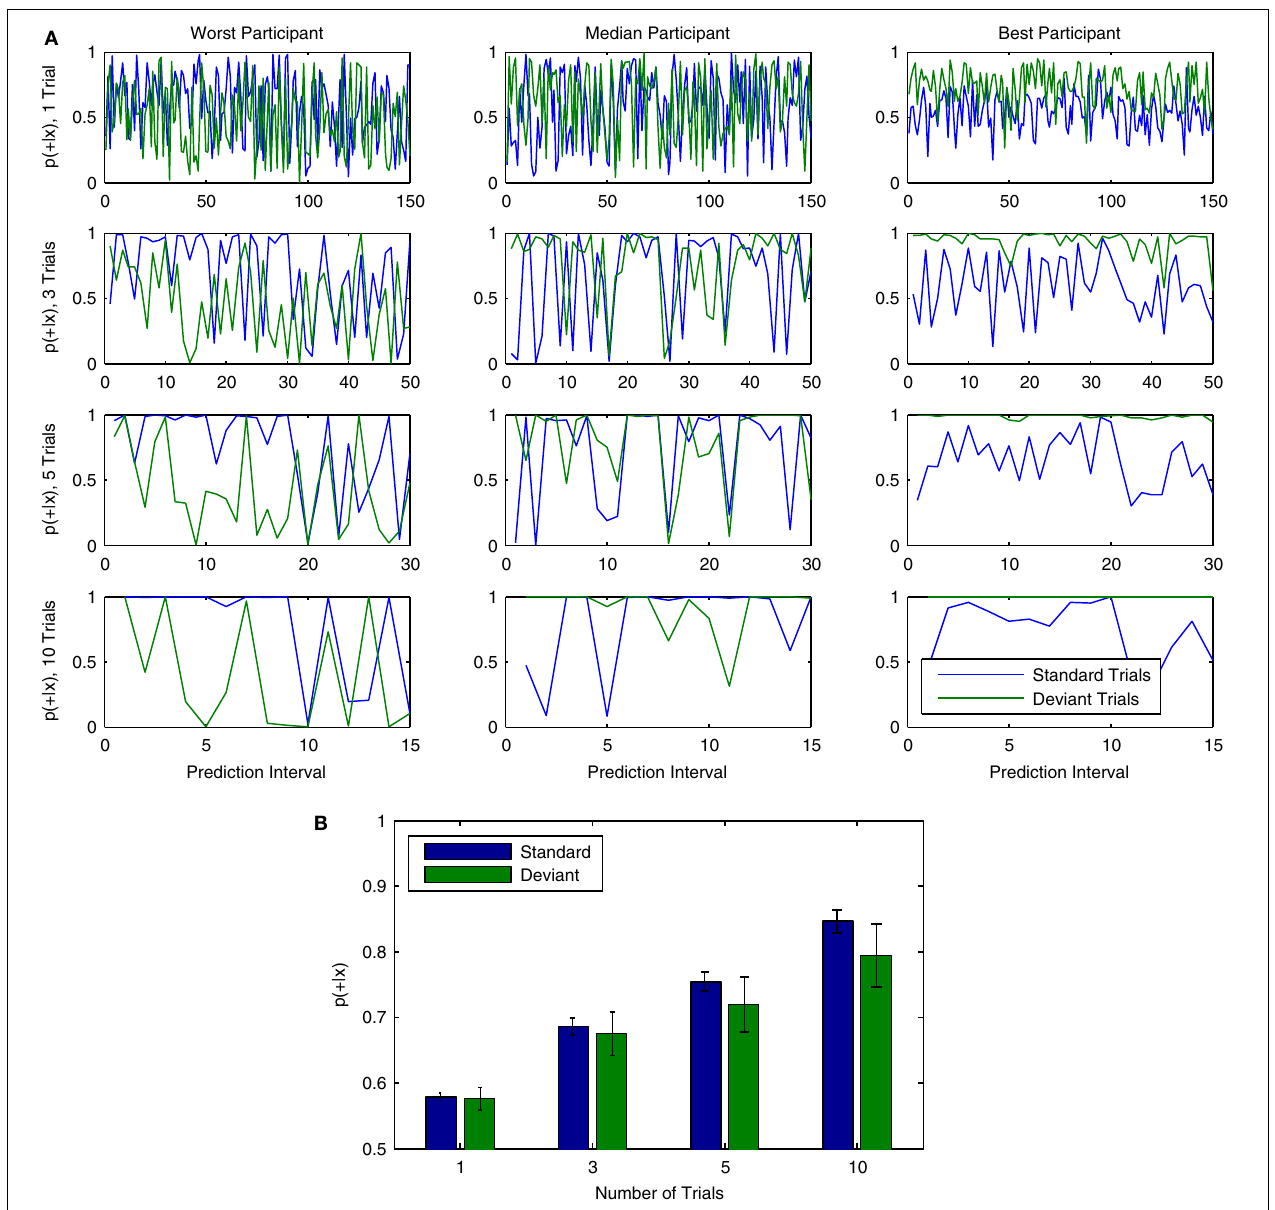
FIGURE 13 | Probabilistic interpretation of classifier output over trials. (A) Data from three representative participants in Dataset 1 (left to right) illustrates a probabilistic interpretation of classifier decisions for single and varying group lengths of (non-overlapping) trials. Results are taken from the first 150 consecutive trials analyzed in the cross-participant analysis. From top to bottom, the number of trials used to make predictions about ongoing brain responses is varied, using either 1, 3, 5, or 10 trials. This effectively reduces